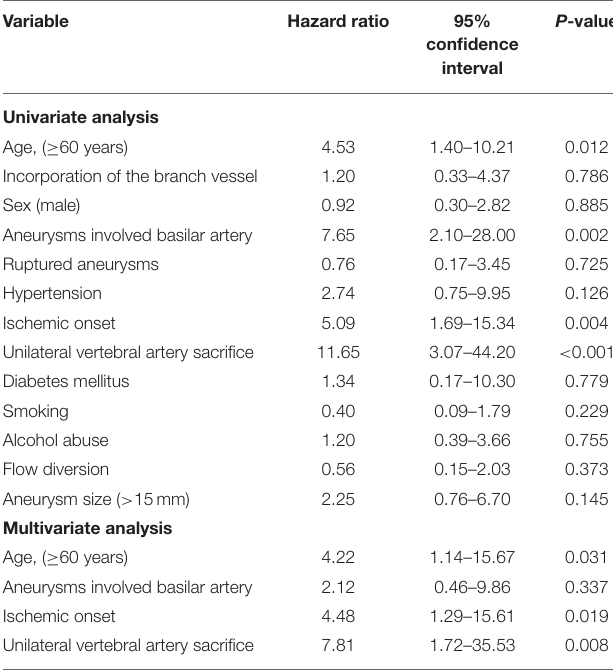
TABLE 4 | The univariate and multivariate Cox regression analysis for postprocedural